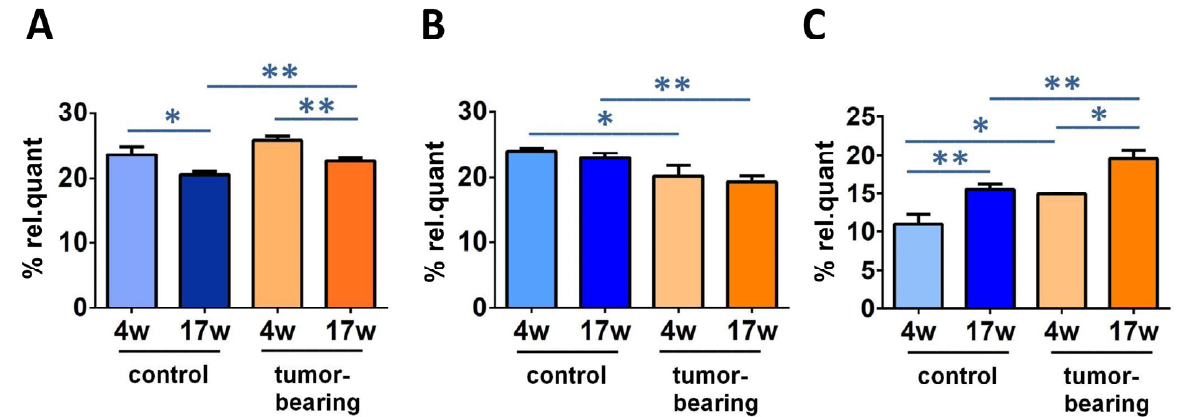
Figure 5. Some relevant fatty acid changes in SCID mice cohorts. Comparison of % rel. quant. of ( A )